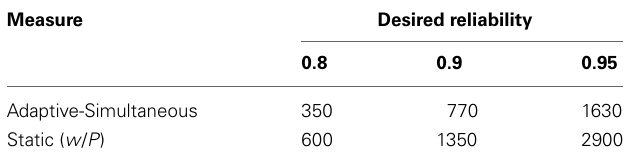
Table 6 | The (approximate) minimum number of trials needed to reach a reliability of 0.8, 0.9, and 0.95 for the adaptive and static simultaneous tasks,